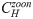
Estimating the relative contributions of zoonotic spillover and human-to-human transmission.Comparison with ABM III.(a) Cumulative number of infections for zoonotic spillover with human-to-human transmission and depletion of susceptibles (‘Poisson with Feedback’ model) generated by the ABM (10 independent runs). The green and red points represent cumulative infections arising from zoonotic and human-to-human transmission respectively. The continuous blue and black line represent the analytical solutions and the isolated contributions of zoonotic, CHzoon, and human-to-human transmission, CHh-h, recalculated with parameters (median values of ζ and κ, right panel) estimated from the MCMC. (b) Traceplot of the time series and histogram of the two parameters: ζ (median 0.008338, mean 0.008364, SE 0.0006919, bandwidth 0.0001162) and κ (median 0.055118, mean 0.055134, SE 0.0033703, bandwidth 0.0005541) number of iterations 10000, burning time 1000, thinning interval 1. The small discrepancy between the parameters and the ones imposed in the ABM (respectively 0.05 and 0.01) is expected as the ABM simulates Bernoulli trials rather than Poisson processes. Full agreement is expected when the number of trials approaches infinity.